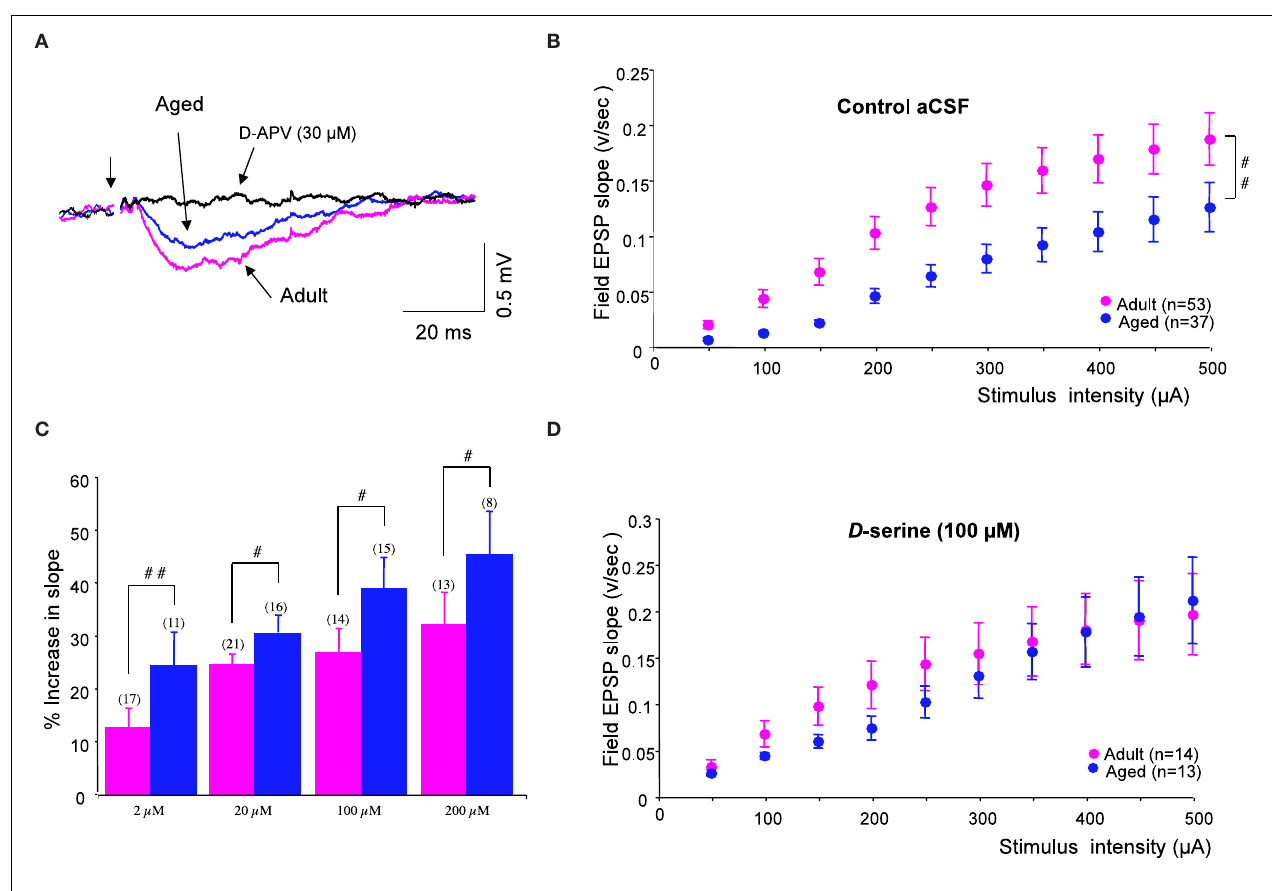
FIGURE 2 | D -Serine prevents age-related defi cits in isolated NMDA-R synaptic potentials. (A) Representative NMDA-R-mediated synaptic potential induced by the stimulation of glutamatergic afferents (fi rst arrow) and recorded in an adult (pink trace) and in an aged (blue trace) rat for a stimulus intensity of 400 µA, and the loss of the synaptic response in the presence of D -APV (30 µM) (black trace). (B) Plot of the mean NMDA-R-mediated fEPSP slope ( ± SEM) against